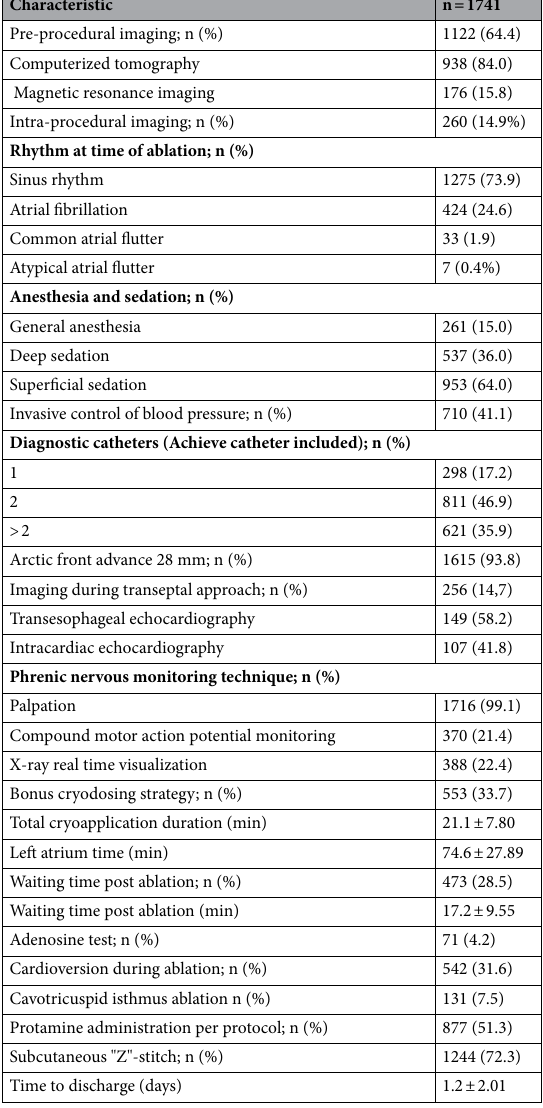
Table 2. Procedural characteristics. Percentage values have been calculated for valid responses and on the total of the sample. Quantitative data are the mean ± standard deviation.